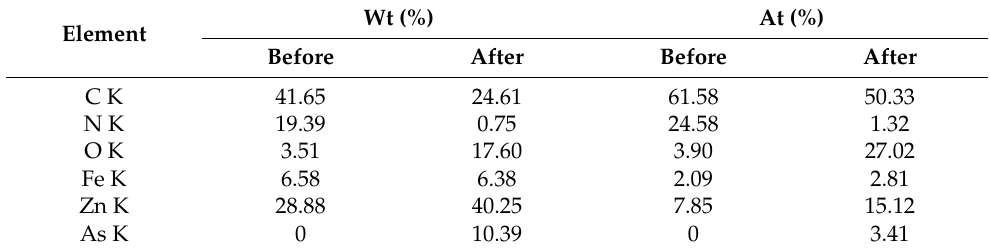
Table 4. EDS analysis of Fe 3 O 4 @ZIF-8 before and after adsorption.